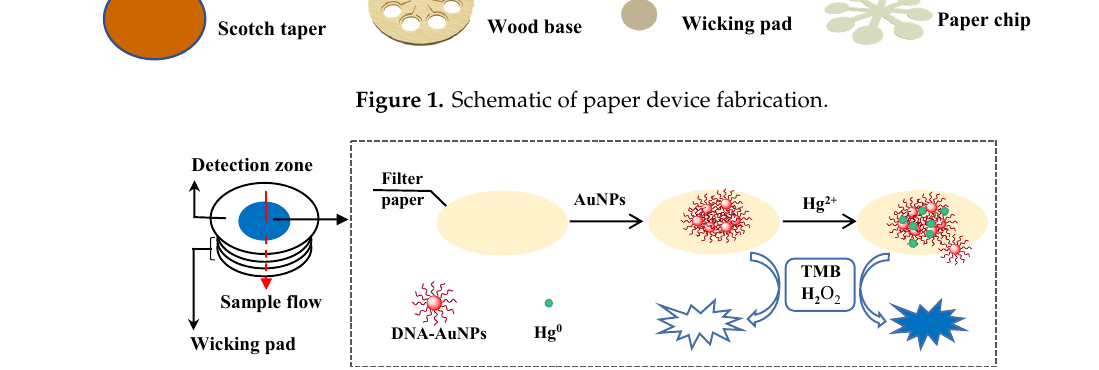
Figure 2. Schematic diagram of Hg 2+ detection.